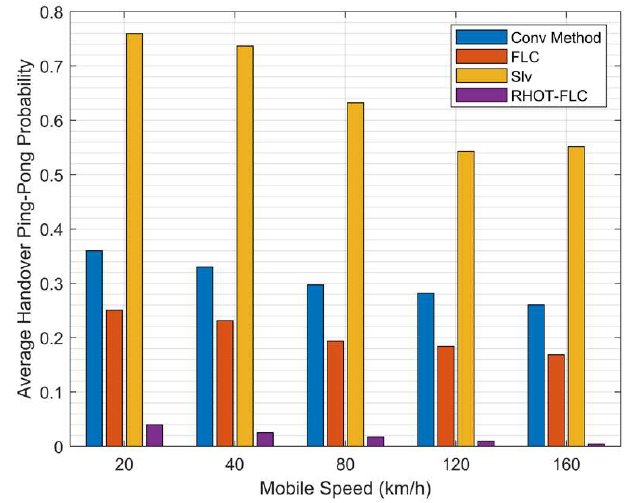
Figure 8. HOPP probability with different mobile speed scenarios.